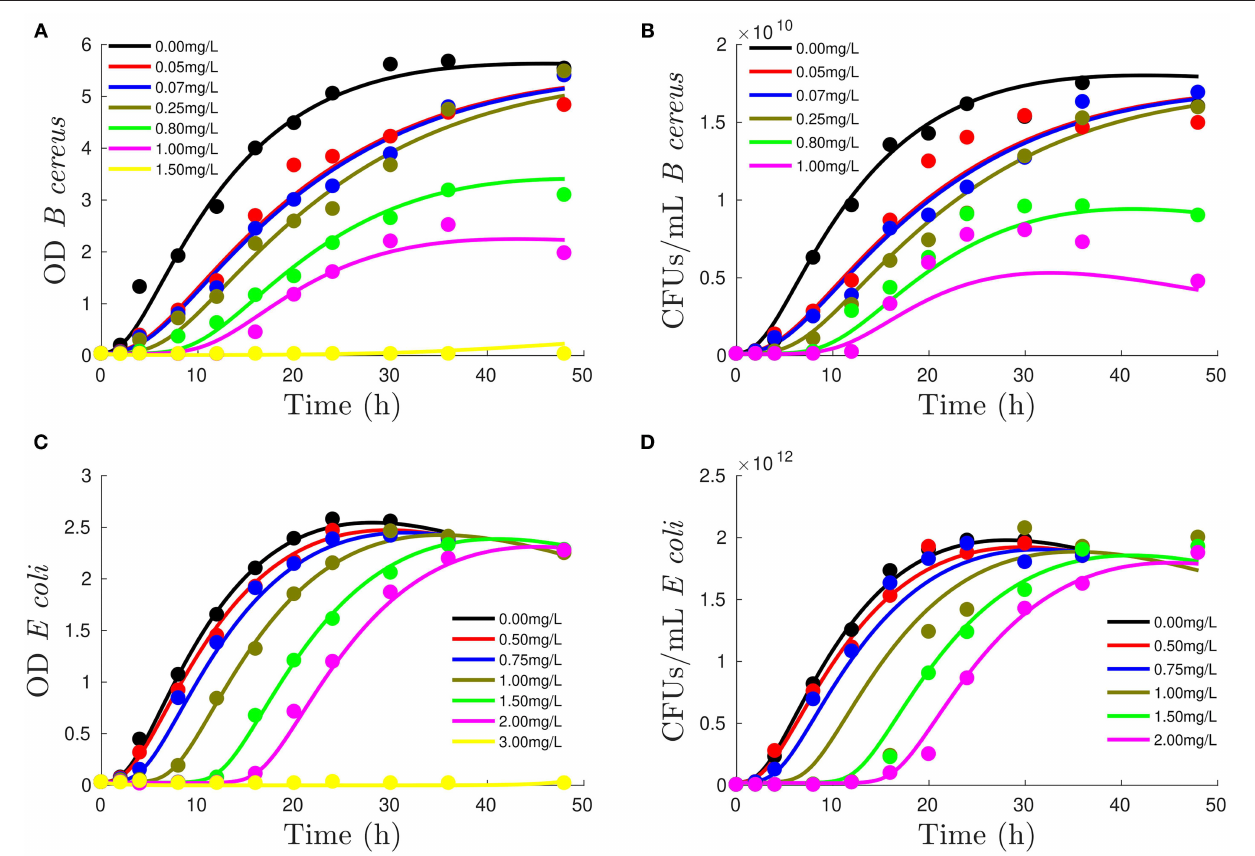
FIGURE 2 | Performance of mechanistic model to reproduce growth measured with OD [figures on the left, (A,C) ] and colony-forming units (CFUs) [figures on the right column, (B,D) ] for B. cereus [first row, (A,B) ] and E. coli [second row, (C,D) ] at different DDAC concentrations (refer to legend). Lines show model output, whereas experimental data are represented by